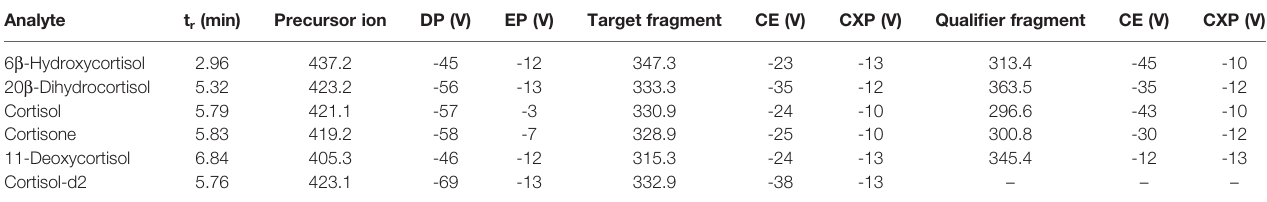
TABLE 1 | Mass spectrometry settings for the target compounds and the internal standard